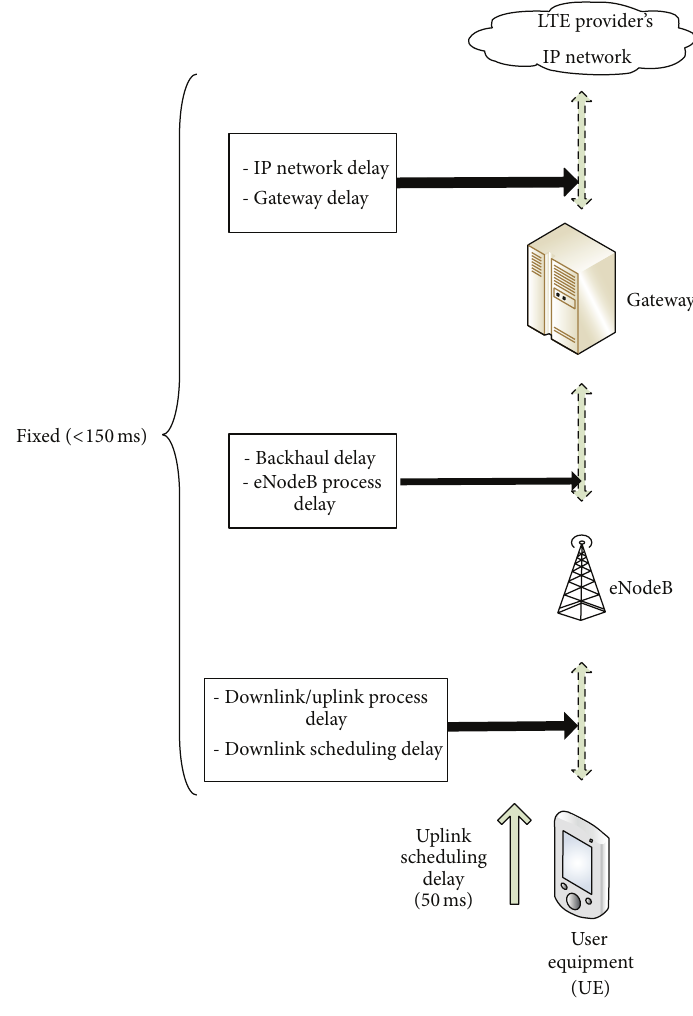
Figure 1: VoIP end-to-end delay components in E-UTRAN